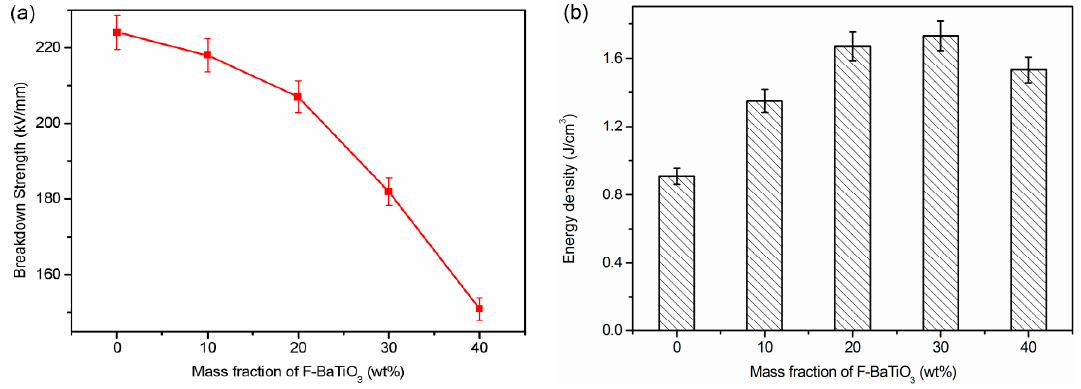
Figure 10. ( a ) The breakdown strength; and ( b ) energy density of the CPEN/F-BaTiO 3 composite films at room temperature.